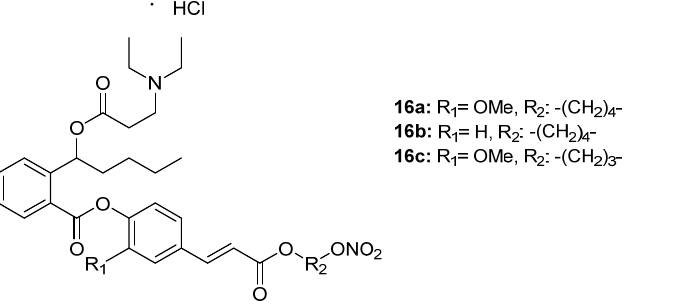
Figure 6. Chemical structure of cinnamic hybrids 16 with antiplatelet and antithrombotic activities [45].